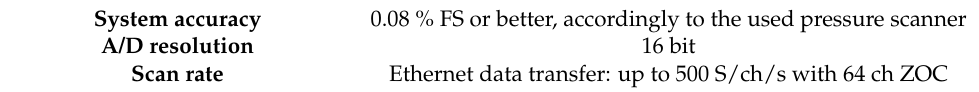
Table 1. The GLE/SmartZOC-100